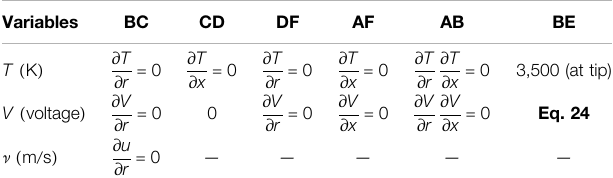
TABLE 2 | Other parameters in the model. TABLE 3 | Boundary conditions for the simulation